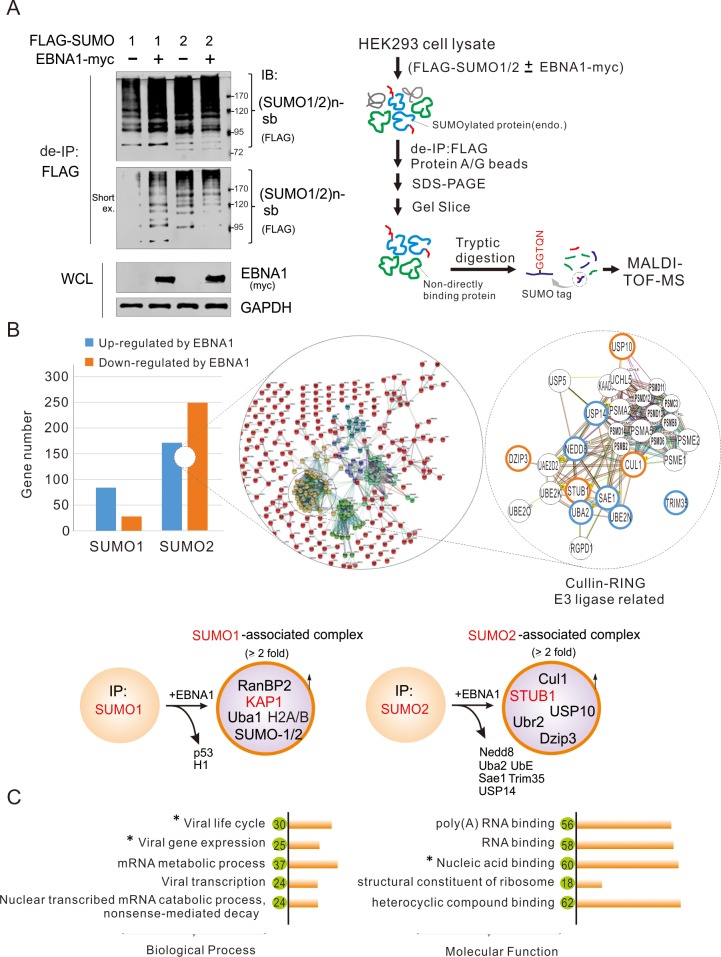
Ectopic expression of EBNA1 has global effects on cellular SUMO1 and SUMO2 modifications.(A) ENBA1 impairs SUMO1 and SUMO2-modified cellular proteins. Whole cell lysates from HEK293 cells co-transfected with expressing plasmids as indicated were analyzed by de-IP and IB with the indicated antibodies. The SUMO1/2-modified substrates [(SUMO1/2)n-sb] from immunoprecipitated complex are shown. The streamlined workflow for identification of profiles of SUMO1- or SUMO2-modified proteins is shown in the right panel. The heatmap and identified target proteins are shown in S3 Fig and S2 and S3 Tables. (B) Venn diagram of identified proteins with SUMO1/2 modification in the presence of EBNA1 by MALDI-TOF-MS. The number is obtained based on peptides of the proteins detected from mass spectrum (MS) with at least two-fold change from panel A. In the right panels, the hypothetical regulatory circuit of EBNA1-mediated SUMO2 modification of target substrates is shown, and the zoom-in of the core network with Cullin-RING E3 ligase-related molecules interconnected hubs is displayed. Blue nodes denote proteins significantly upregulated by EBNA1, and orange nodes are proteins significantly downregulated by EBNA1. The SUMO1- or SUMO2-target proteins by EBNA1 in the SUMO1/2-associated complex with more counts of peptide hits detected by MS are highlighted in the bottom panels. (C) The cellular pathways and functional clustering analysis of the identified proteins from SUMO2-associated complex mediated by EBNA1. The number of SUMO2-associated proteins is shown in the green circle. The related function of EBNA1 verified in this study is indicated using an asterisk.